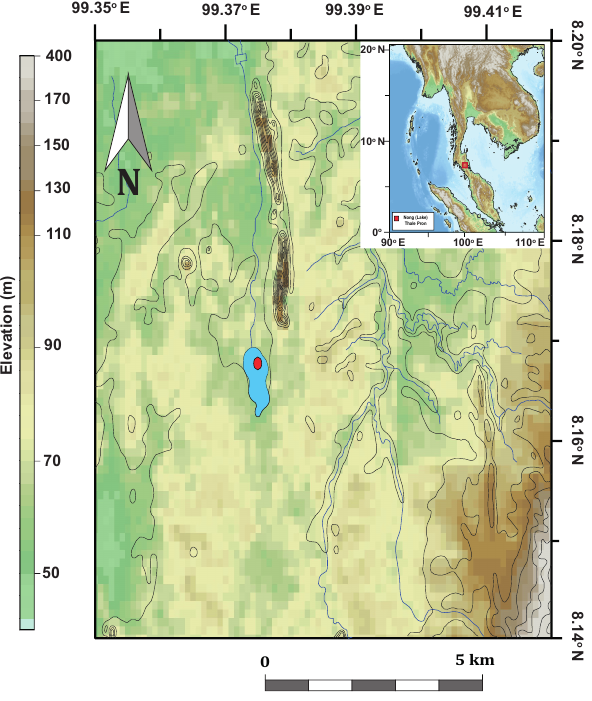
Figure 1. Location of the study area in southern Thailand and to- pography of Lake Nong Thale Prong (shaded blue). A red circle shows the coring site. For interpretation of the references to colour, the reader is referred to the web version of this